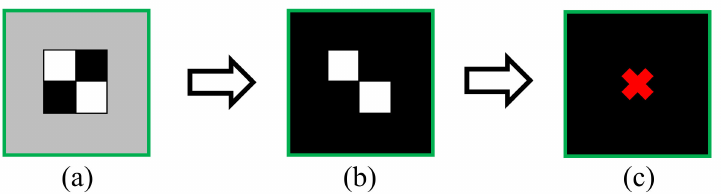
Figure 3. Schematic diagram of ( a ) the region of interest (ROI) containing a cross patch; ( b ) the binary image of the ROI after thresholding; ( c ) the location of the target determined as the centroid of white